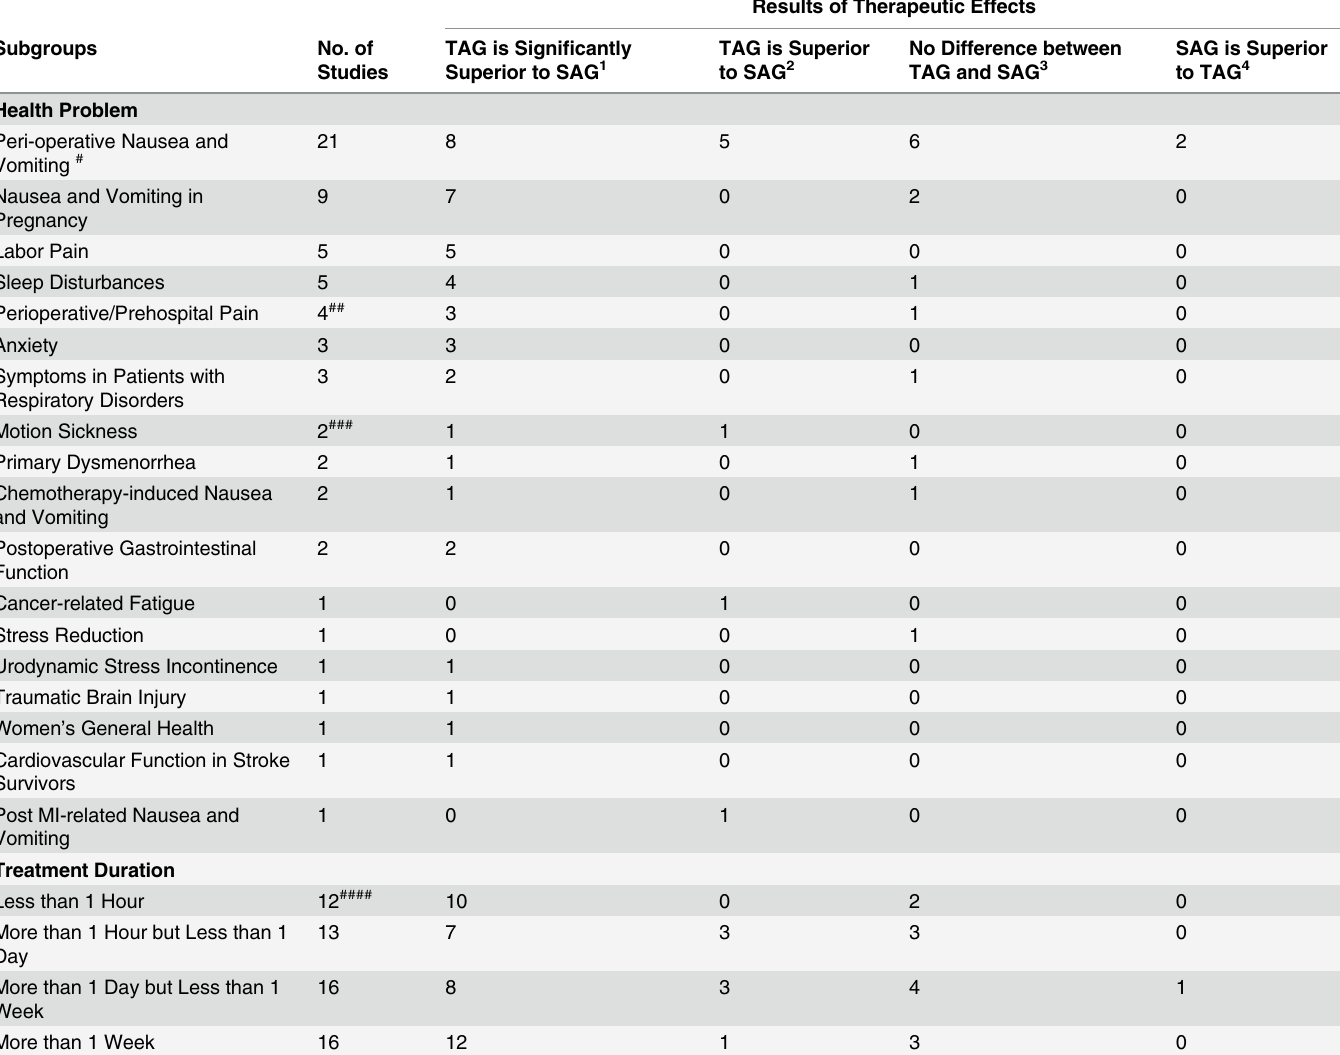
Table 5. Summary of the Therapeutic Outcomes based on Different Health Problems and Treatment Durations.